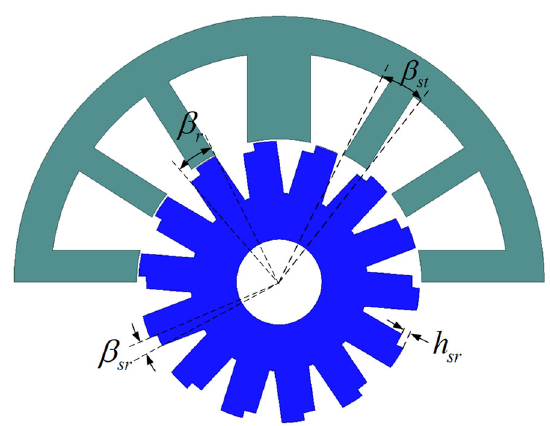
Figure 3. Important parameters of the stepped rotor BLSRM.